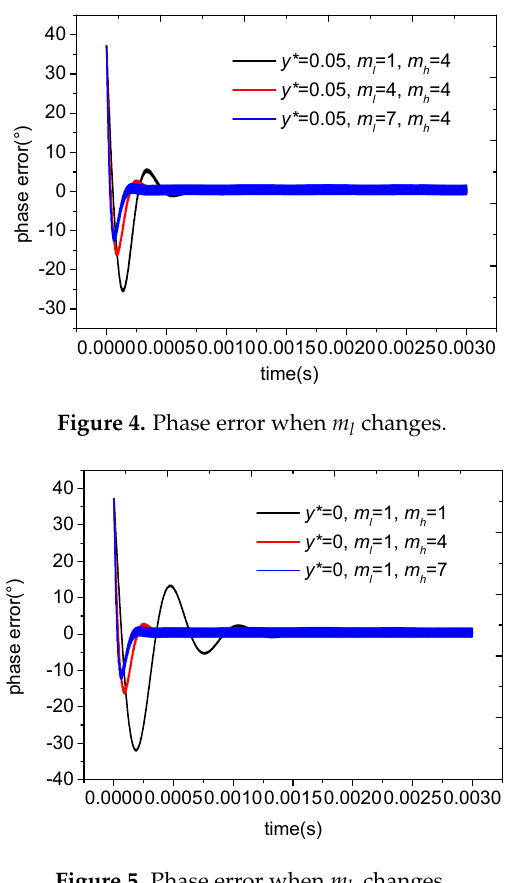
Figure 5. Phase error when m h changes.